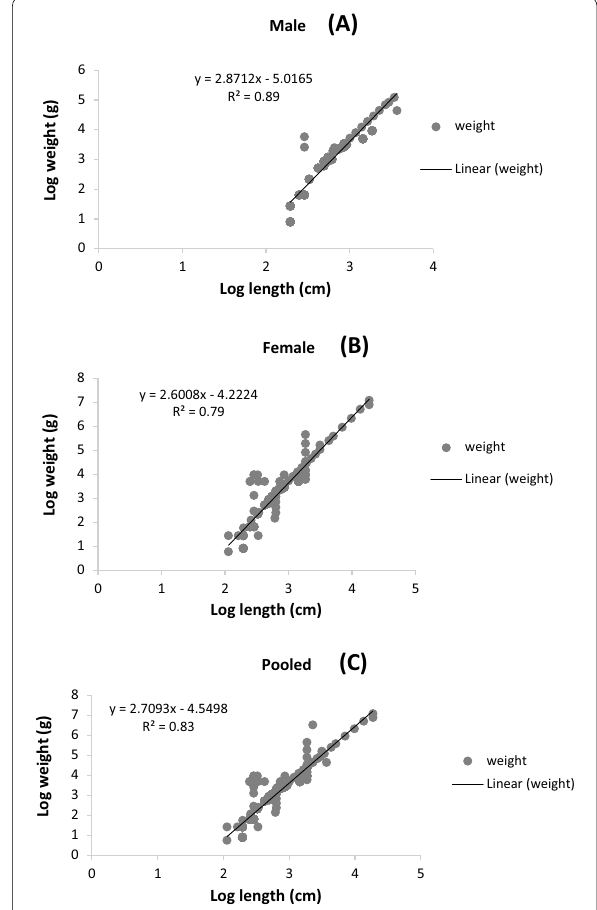
Fig. 2 The coastal areas of Mumbai, with the length–weight relationship of Charybdis callianassa between males and females recognized ( a male, b female and c pooled sex)